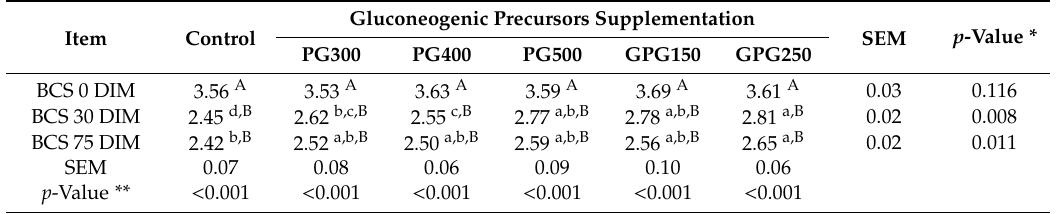
Table 2. E ff ect of di ff erent treatment regimens by gluconeogenic precursors and the time of assessment on body condition score